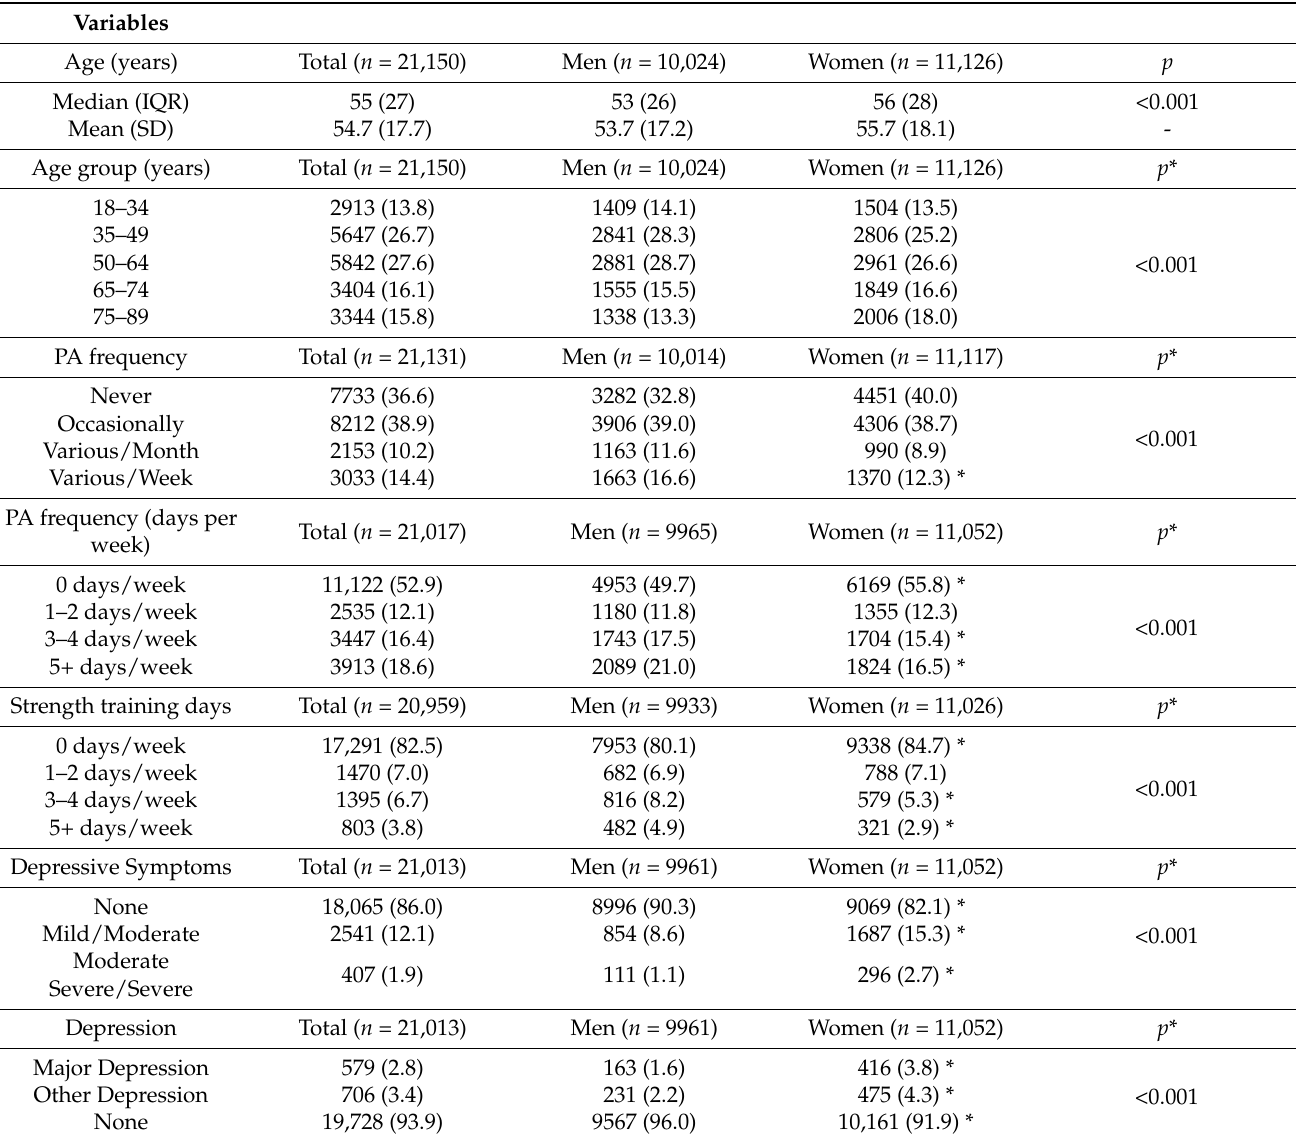
Table 1. Characterization of the Spanish population aged 18 to 89 years from the EESE2020, and gender